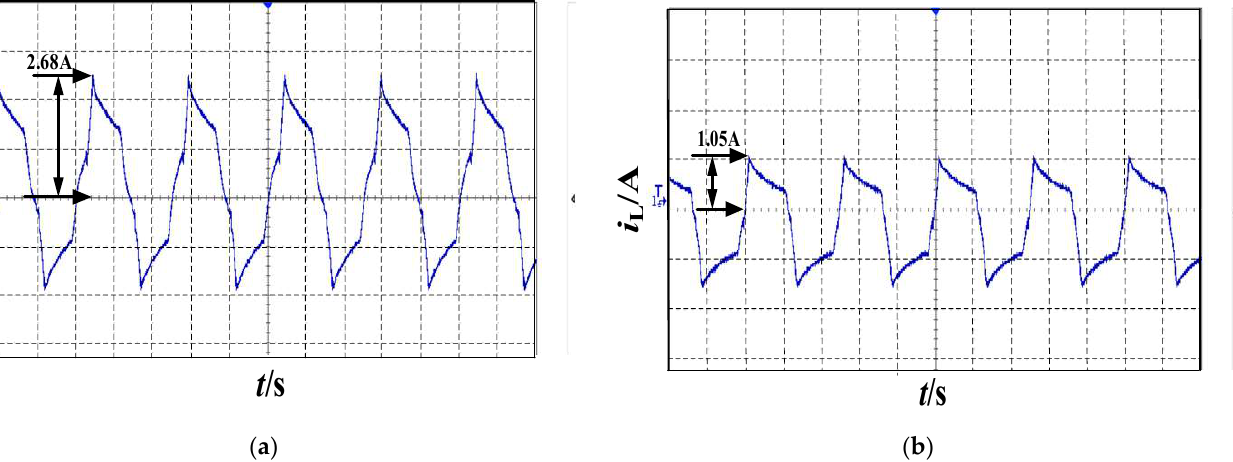
Figure 18. Inductor current waveforms: ( a ) inductor current waveform before inductor current stress optimization; ( b ) inductor current waveform after inductor current stress optimization.